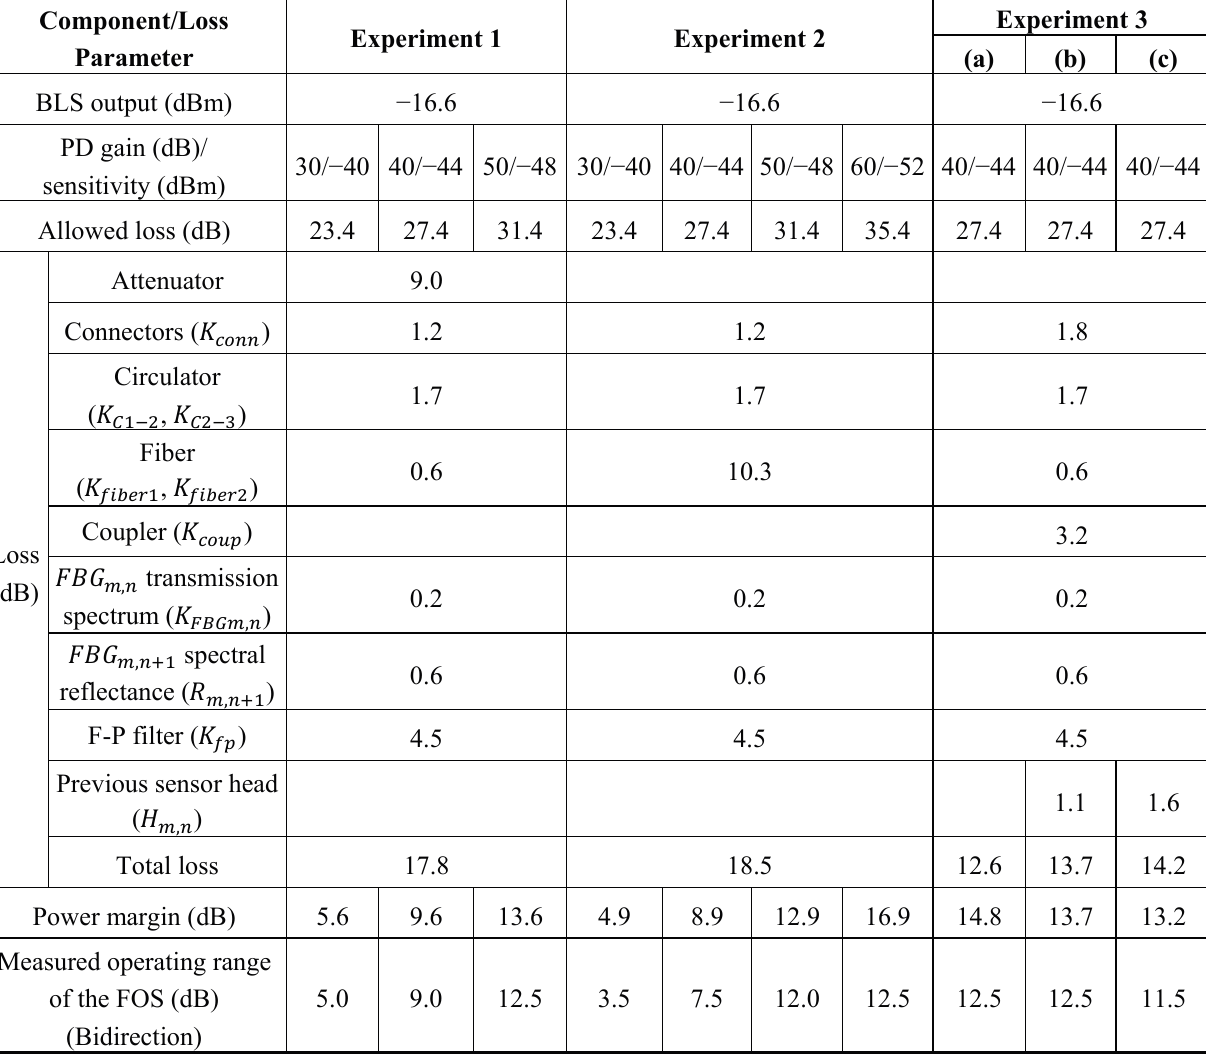
Table 2. Spreadsheet for calculating the proposed FOS power